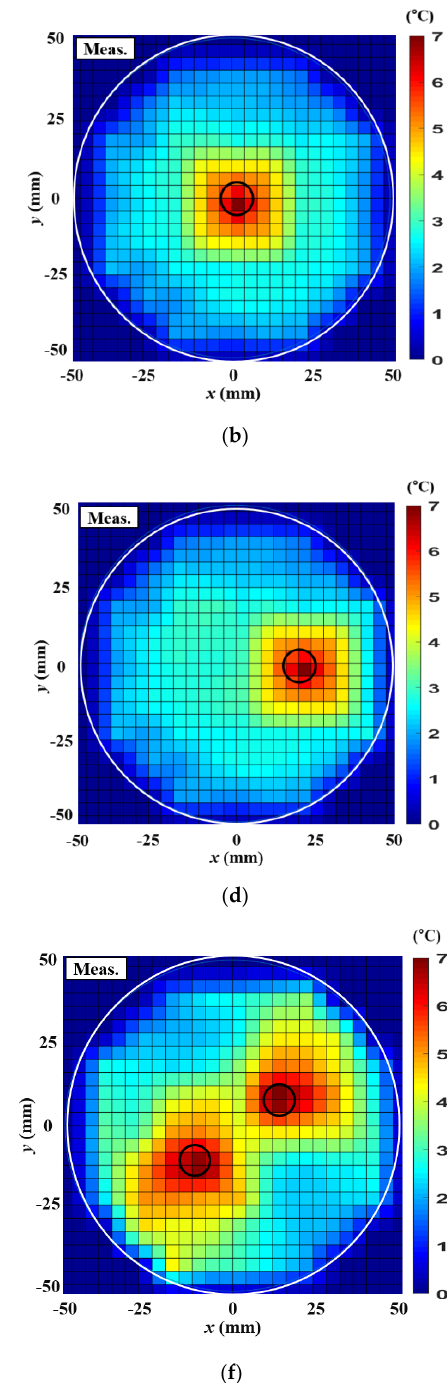
Figure 12. The 2D sections of temperature distribution after the 1-h heating on a single tumor at (0,0) mm: ( a ) simulation result and ( b ) measurement result. Temperature distribution after 1-h heating on a single tumor at (20,0) mm: ( c ) simulation result and ( d ) measurement result. Temperature distribution for 1-h heating on multiple tumors with phase compensation at (15,10) mm and (−15,−10) mm: ( e ) simulation result and ( f ) measurement result.